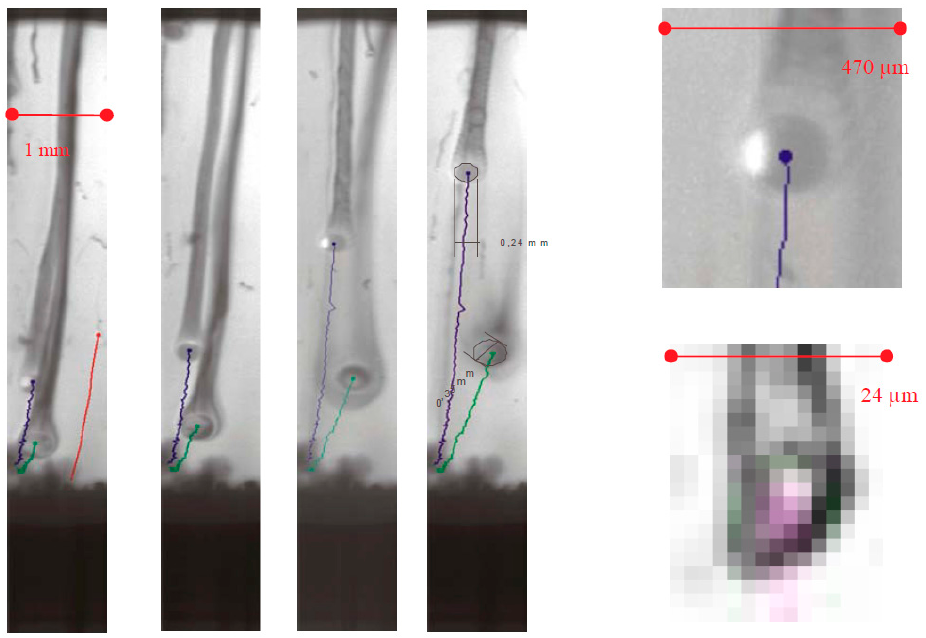
Figure 24. Alumina particles in composite propellant. Reprinted with permission from Ref. [42] (2022).